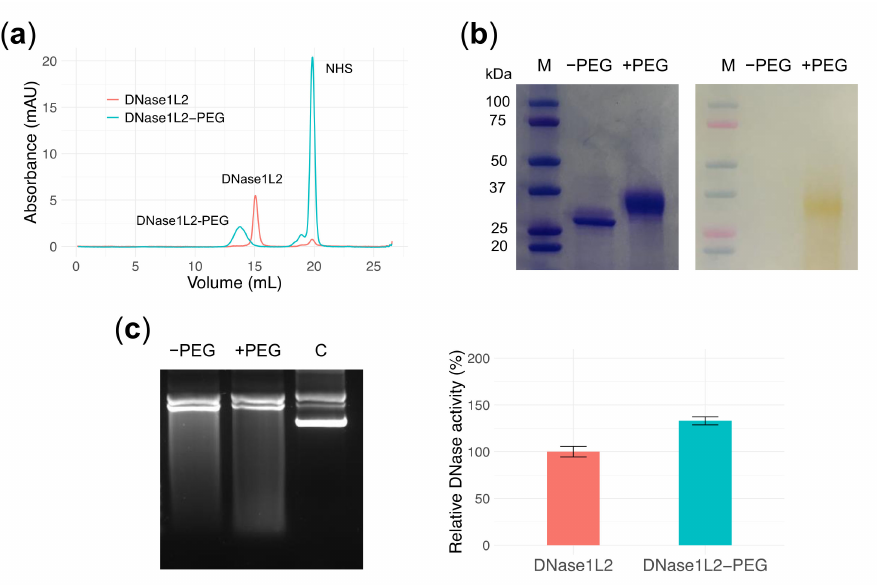
Figure 6. PEGylation of DNase1L2. ( a ) Size-exclusion chromatogram of DNase1L2 (salmon) and reaction mixture of DNase1L2 and PEG-NHS (cyan). Representative peaks are labelled. ( b ) SDS-PAGE of native and PEGylated DNase1L2 with Coomassie (left panel) and PEG-specific barium iodide dye (right panel) staining. M: marker. ( c ) Agarose gel electrophoresis (left panel) and densitometric analysis (right panel) showing DNase1L2 and DNase1L2-PEG activity on supercoiled plasmid DNA. Data are means ± SD of two independent